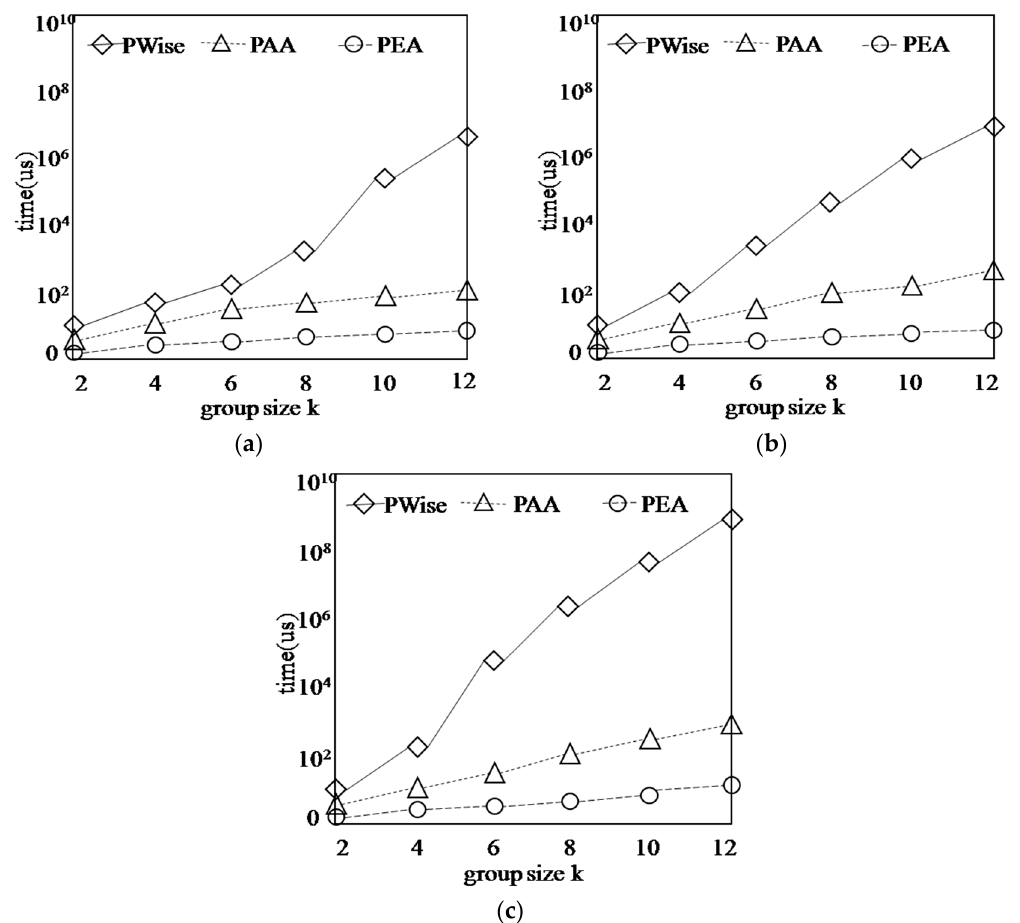
Figure 16. Finding G-Skyline with different group size k . ( a ) COR; ( b ) IND; ( c ) ANTI-COR.